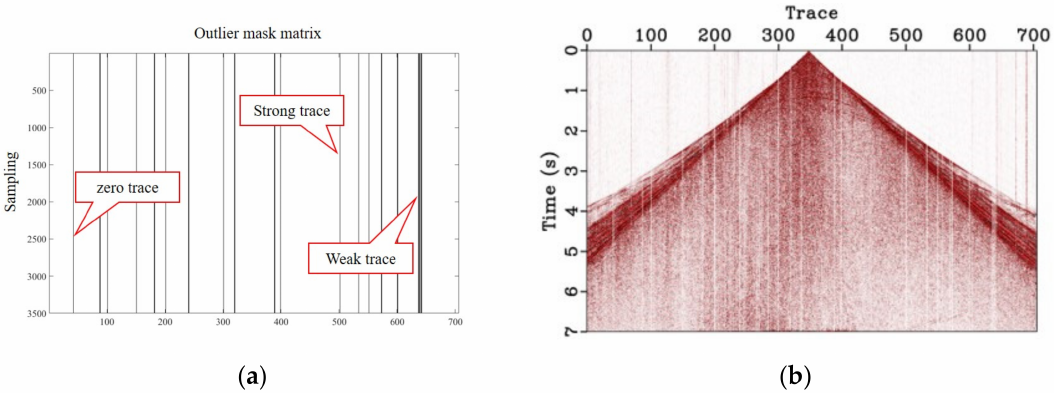
Figure 14. The removed outlier trace. ( a ) Outlier mask matrix ( Φ t ). ( b ) Data without outlier noise ( d s ).